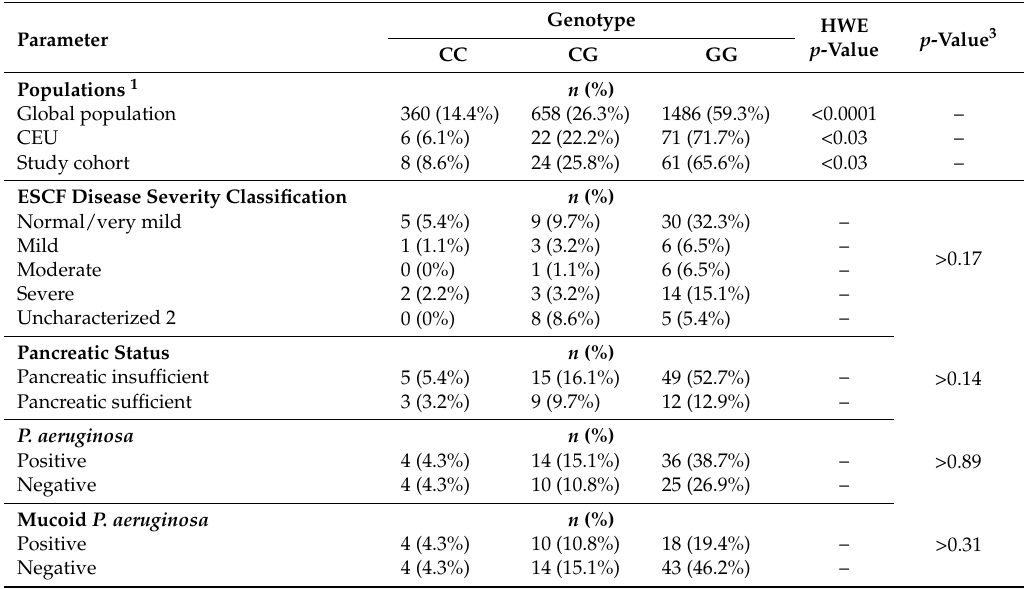
Table 3. Frequency distribution of